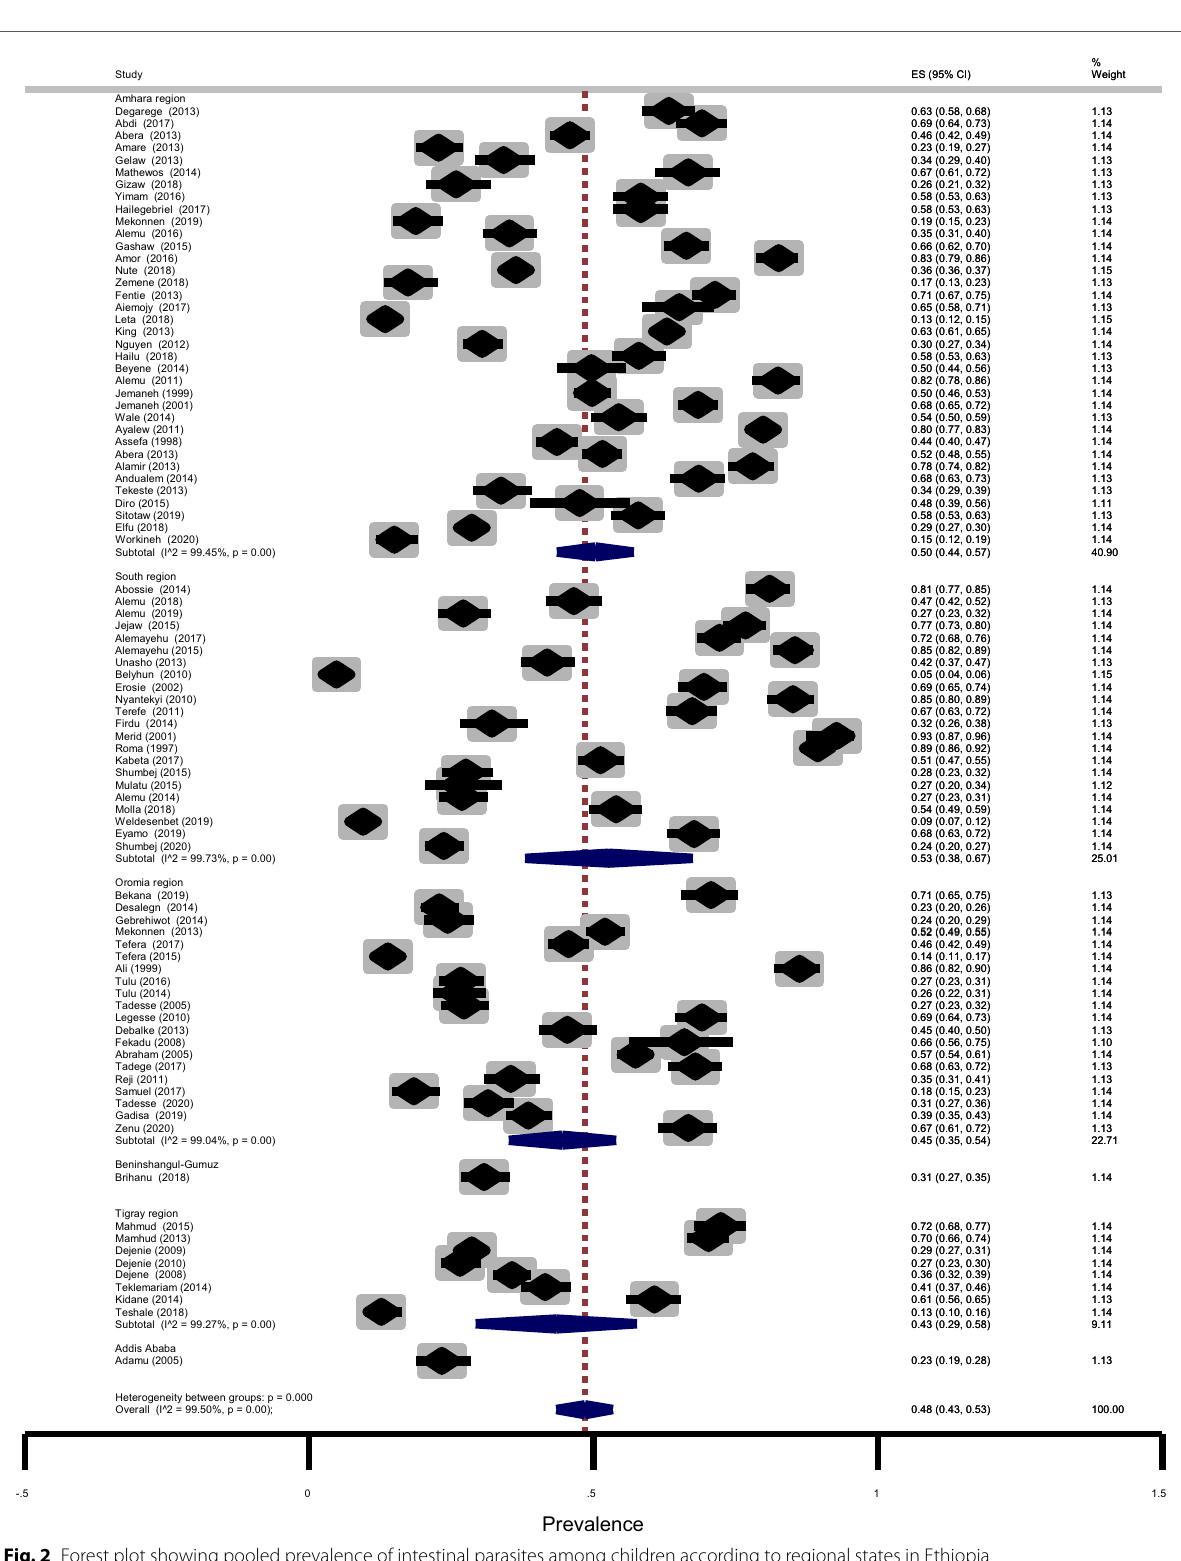
Fig. 2 Forest plot showing pooled prevalence of intestinal parasites among children according to regional states in